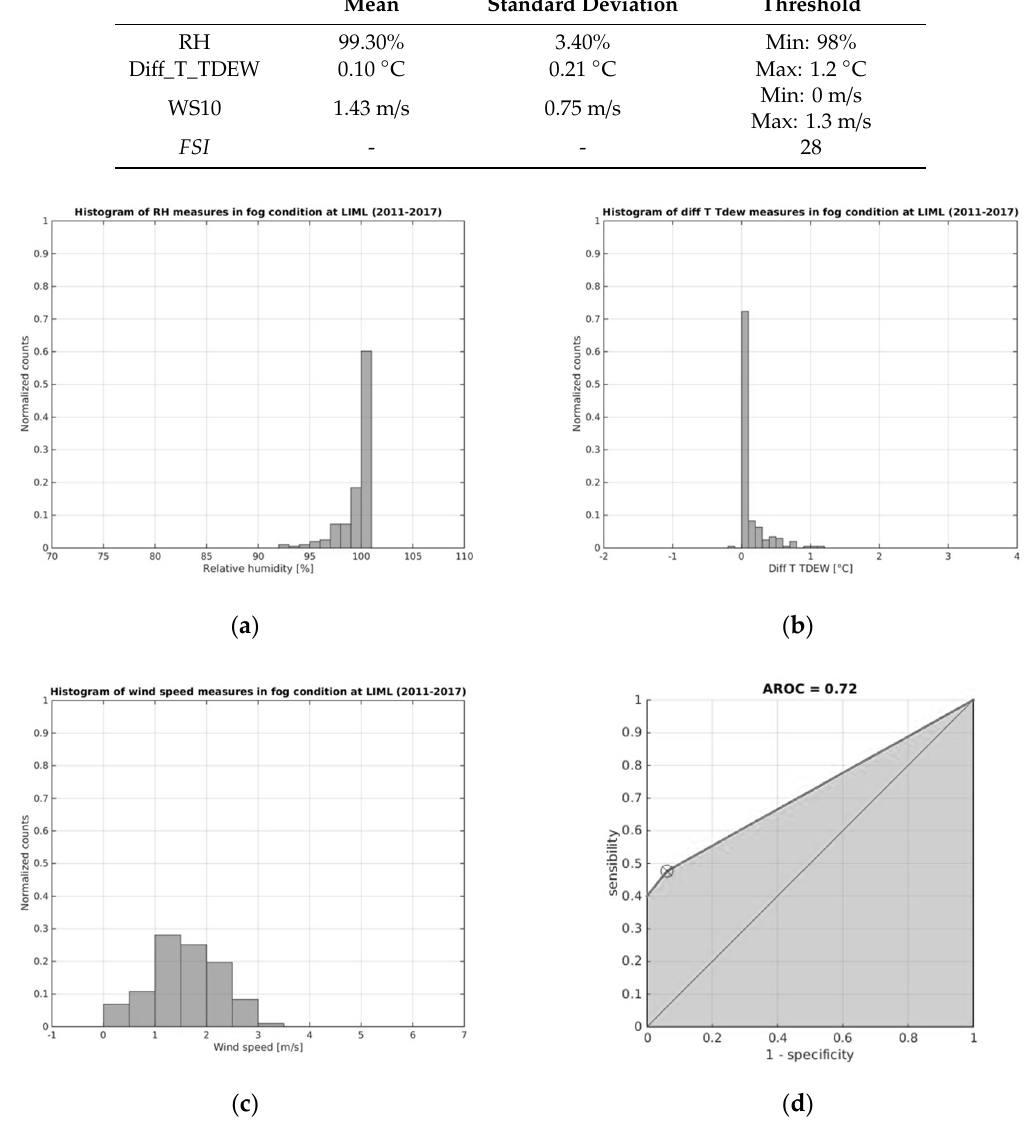
Figure 5. Histograms of the measurements of ( a ) relative humidity, ( b ) surface temperature / dew point difference, ( c ) wind speed in fog condition at Milano Linate in the period January 2011–December 2017 and ( d ) receiving operating characteristic (ROC) curve with FSI_thresh = 28.